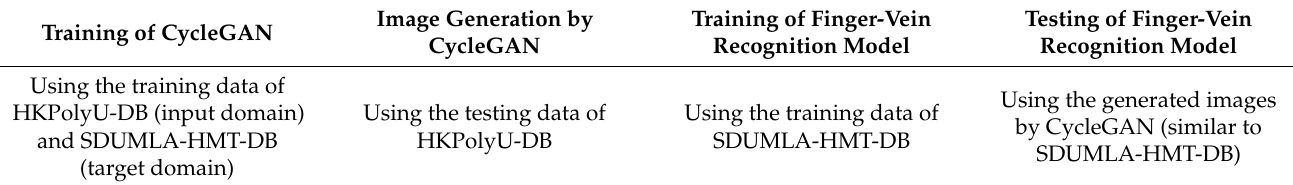
Table 5. Experimental scenario of our domain adaptation method (unit: %).